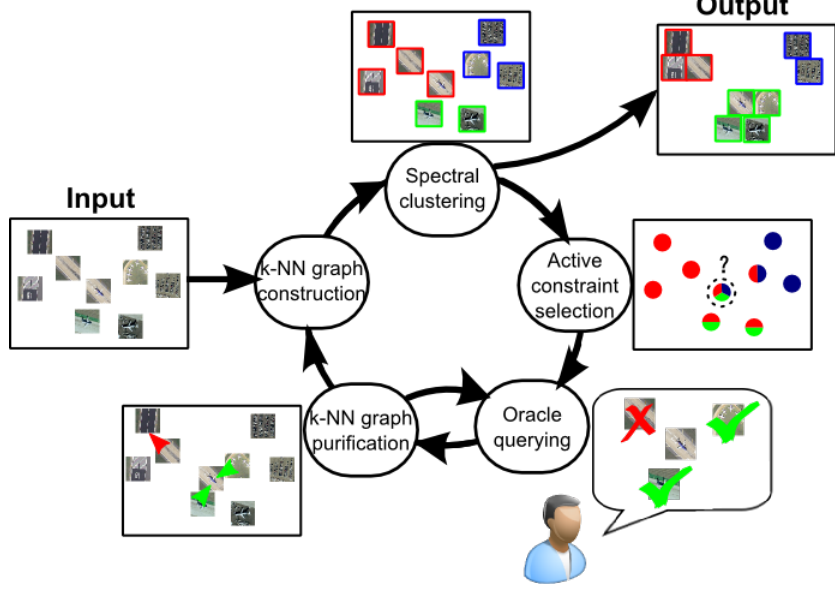
Figure 2. Flowchart for the active spectral clustering of remote sensing images. Given a set of images (or image regions) as inputs, we first construct the k -nearest neighbor ( k